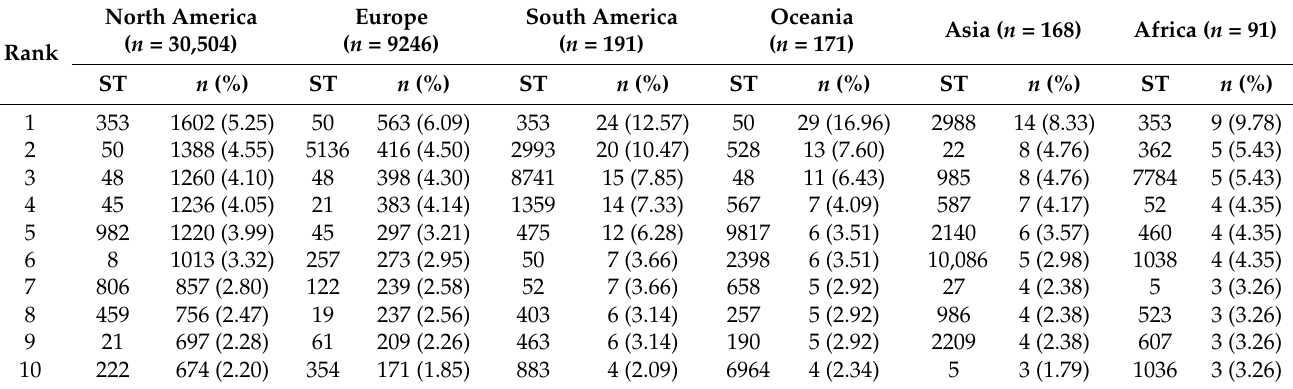
Table 1. Top ten commonly detected Campylobacter jejuni sequence types (STs) recovered from the whole genome sequence in the NCBI Pathogen Detection Database ( n = 40,371) from each continent.